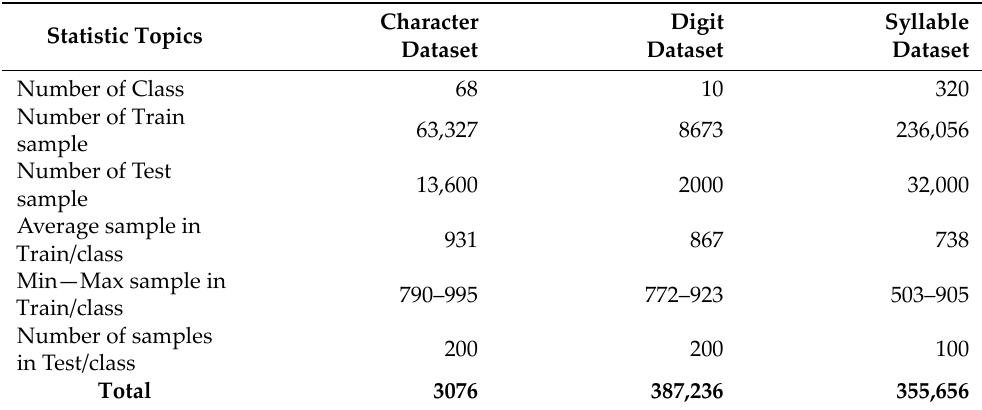
Table 3. Number of images in our proposed Burapha‑TH datasets.